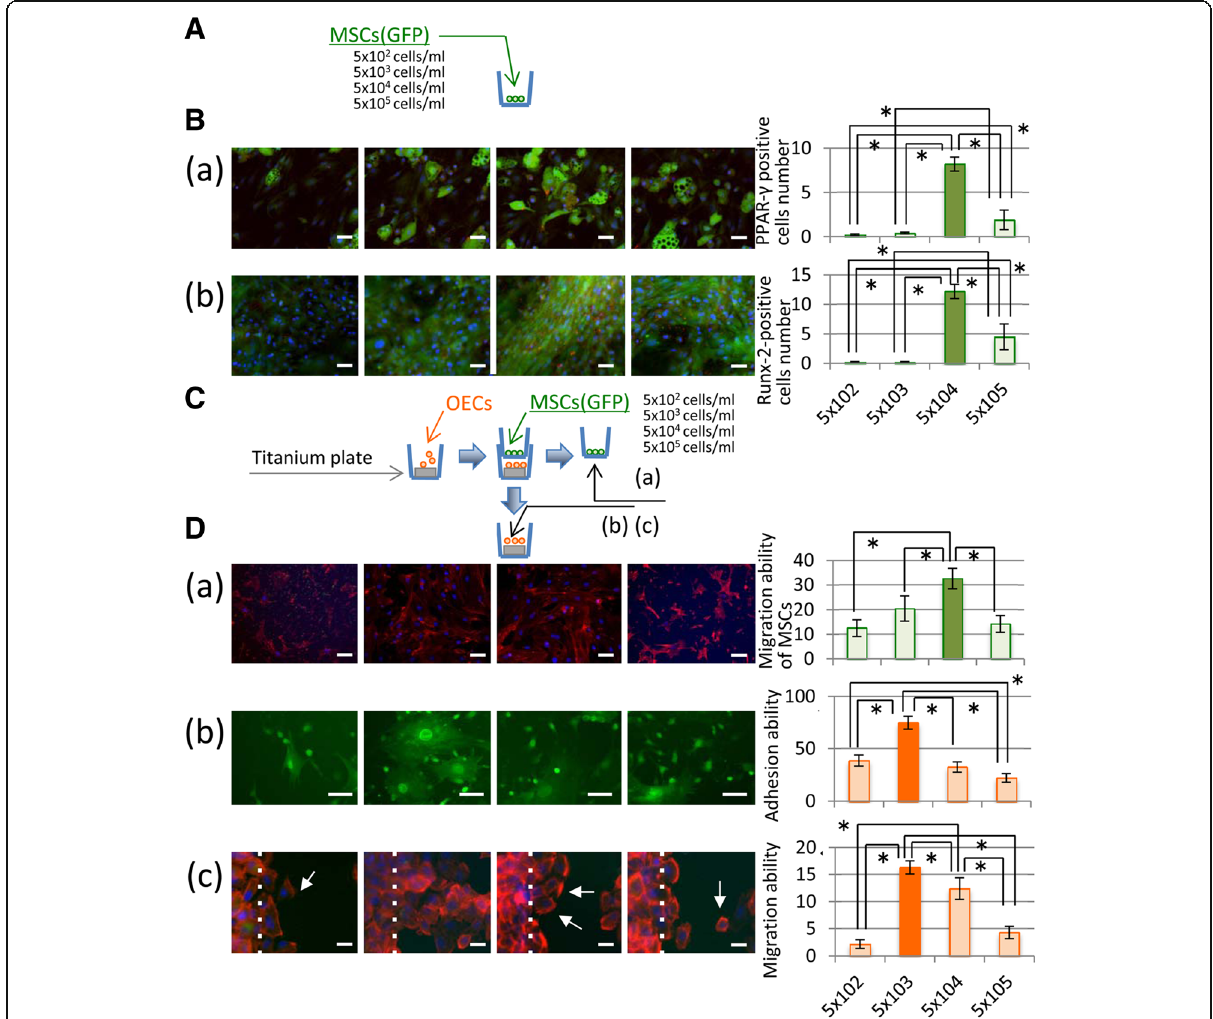
Fig. 7 Relationship between cell density and differentiation. A MSCs were seeded at four concentrations (5 × 10 2 , 5 × 10 3 , 5 × 10 4 , 5 × 10 5 MSCs/ ml) into culture wells. B Multipotent differentiation of MSCs related to cell density. (a) Adipogenic differentiation of MSCs. The graph shows quantification of PPAR- γ -positive cell numbers as differentiated adipocytes from independent experiments (means±SD). (Bar=40 μ m) (b) osteogenic differentiation of MSCs. The graph shows quantification of Runx-2-positive cell numbers as differentiated osteoblasts from four independent experiments (means±SD). (Bar=50 μ m) C schematic of in vitro coculture study. D Relationship between MSCs and OECs in coculture. (a) Quantification of MSCs number in the upper Transwell insert chamber to determine MSC migration through the 8- μ m pores. (Bar=20 μ m) (b) OEC adhesion assay. Data show the percentage of OECs under MSC coculture. Bars represent the means±SD of four independent experiments. * p <0.05 (c) scratch assay. OECs were cultured for 3 days then observed by immunofluorescence staining for actin filaments (red). The white dotted line shows the limit of the wound area into which the cells migrated, while the white arrow indicates migrating cells. (Bar=20 μ m) the right panel graphically shows the number of migrating cells under each condition. Bars represent the means±SD of four parallel experiments. * p